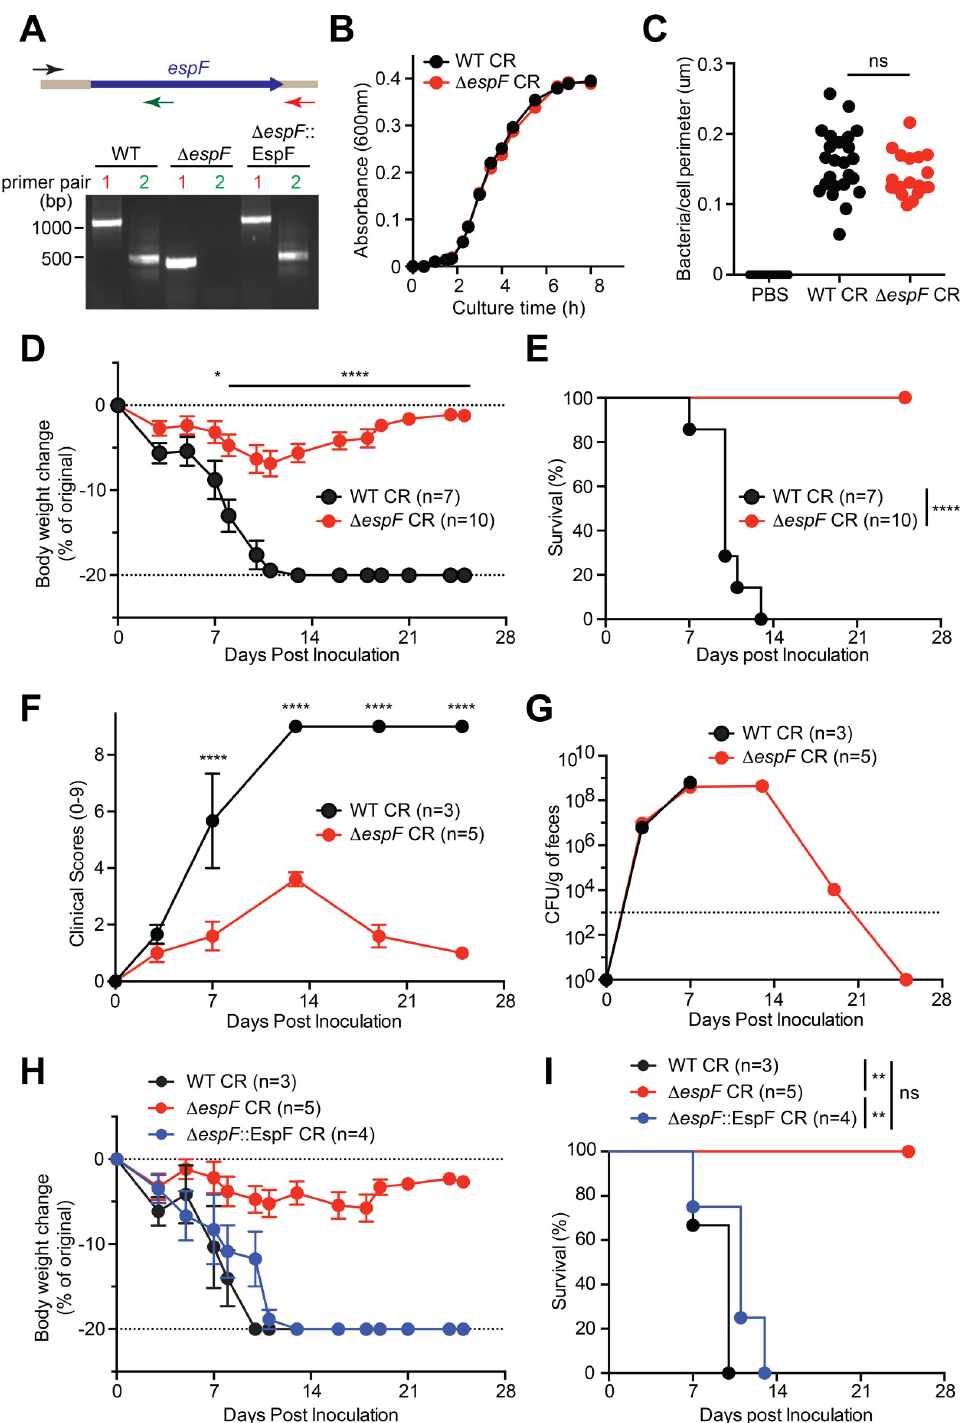
Fig 2. EspF is critical for CR infection-induced morbidity and mortality in Il22 -/- mice. A. Upper, diagram shows CR espF gene and PCR products amplified using a common forward primer and pair 1 reverse primer (in red), or pair 2 reverse primer (in green). Bottom, representative image of amplified PCR products using the indicated primer pairs from the CR strains as indicated. B. Growth curves of WT and Δ espF CR in LB medium, at 1: 150 dilutions from the overnight cultures. C. Colon epithelial cells (CEC) derived Il22 -/- mouse were infected in suspension with PBS, WT or Δ espF CR at 100 MOI for 3h, followed by immunofluorescence staining for CR-specific antisera, with nuclei counterstained by